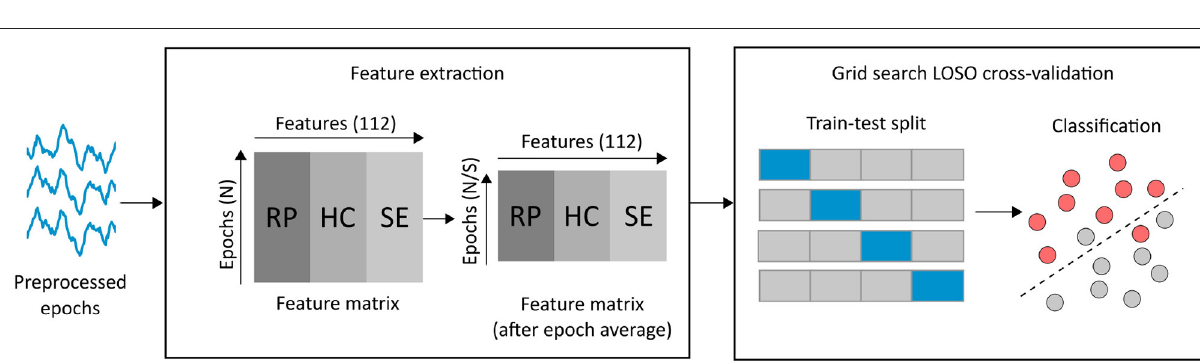
FIGURE 2 | EEG signal processing pipeline. First, we applied a FIR filter with bandpass 1–45 Hz to remove the power line interference and retain the spectral content in the desired frequency range. Then, we segmented the filtered EEG into 4-s epochs without overlapping. Finally, we performed automated artifact removal through Autoreject algorithm and ICA.